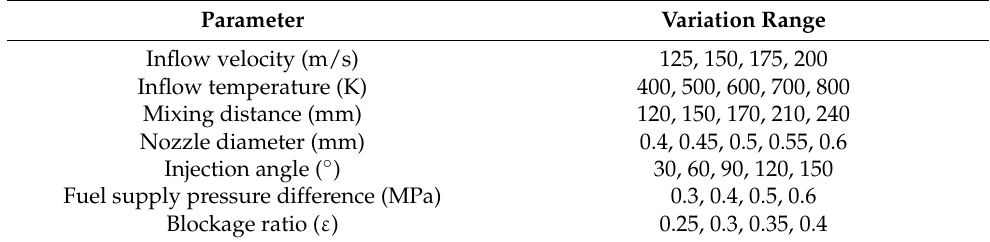
Table 1. The parameter variation ranges.